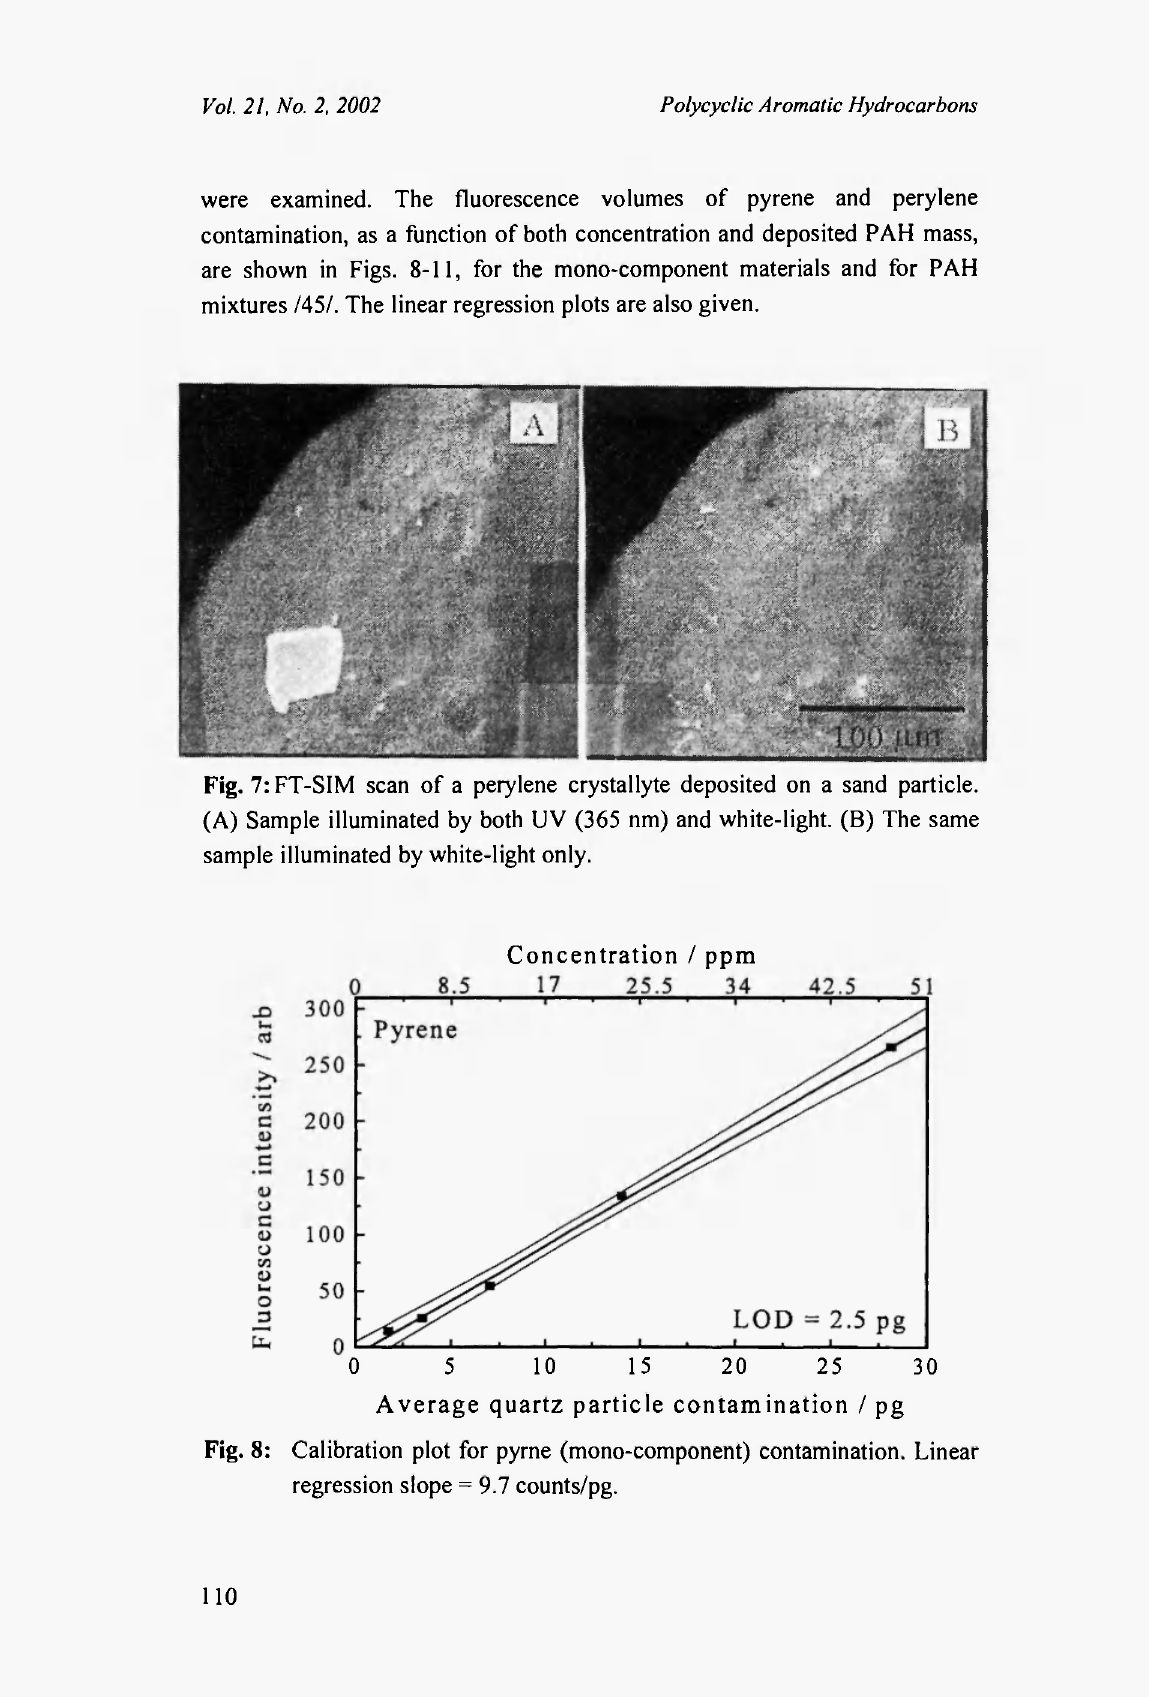
0 5 10 15 20 25 30 A v e r a ge quartz particle c o n t a m i n a t i on / pg Fig. 8: Calibration plot for pyrne (mono-component) contamination. Linear regression slope = 9.7